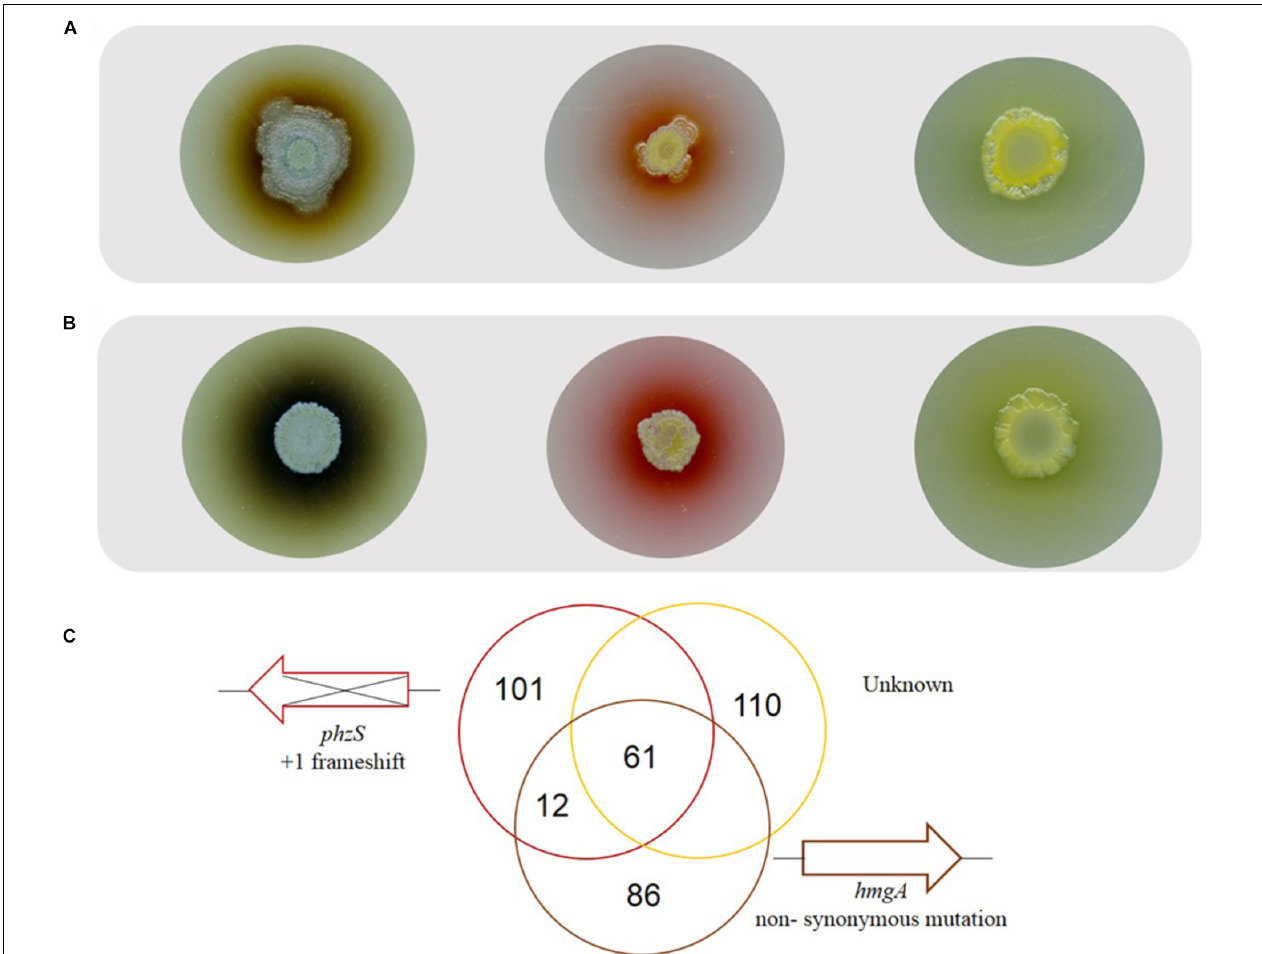
FIGURE 3 | (A) Representative colony morphology analysis of the brown, red, and yellow pigmented variants on TSB agar and (B) TSB agar supplemented with bile highlighting pigment production with further induction in the presence of bile. (C) Whole genome sequence analysis on representative pigmented isolates with sequence comparison analysis undertaken with PA14 or as the reference strain.